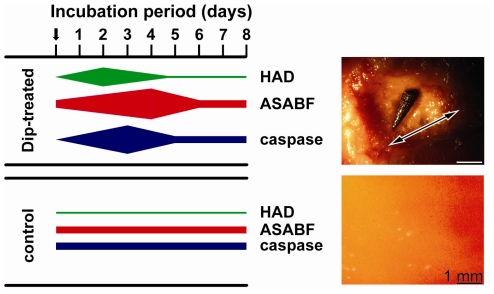
Diagrammatic sketch of the expression levels of HAD, ASABF as well as of the caspase gene in Dip-treated and in control specimens (left). The widths of the bars symbolize the level of expression. At the upper right an image of the surface of a 3-day-old apoptotic area (double-headed arrow) with a gastropod is shown; lower right shows the plain surface of a non-treated specimen.